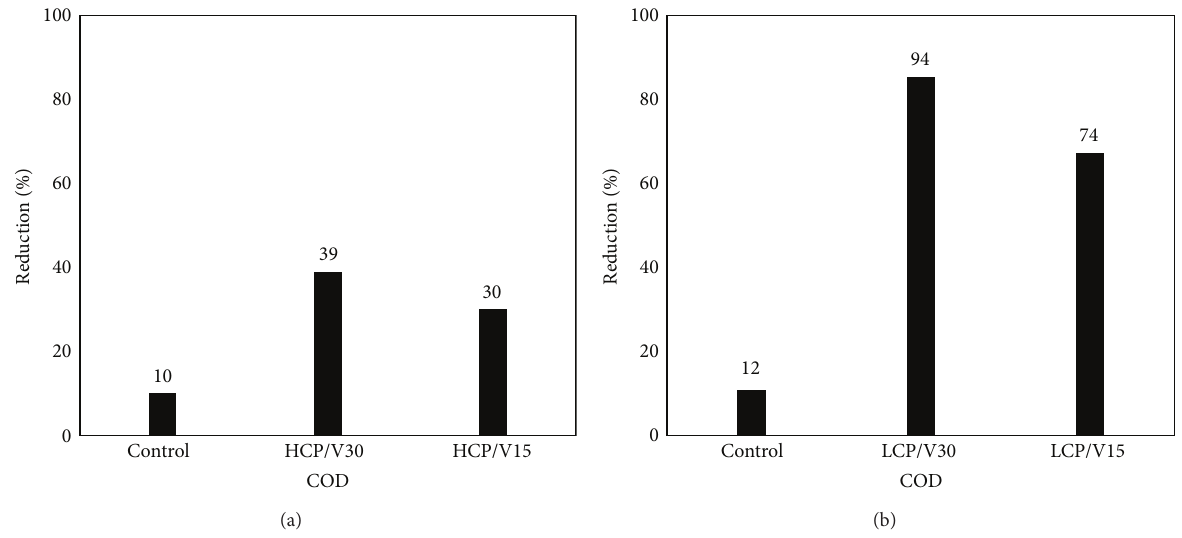
Figure 5: Reduction of COD%: (a) high concentration POME and (b) low concentration POME.